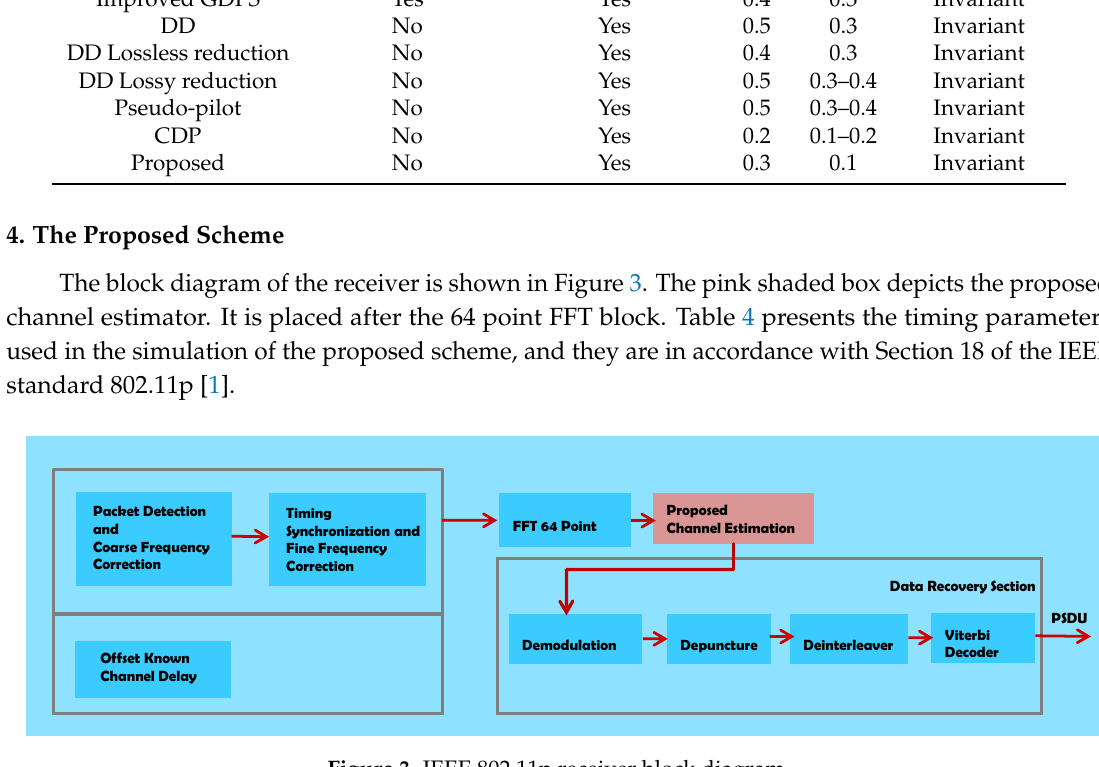
Figure 3. IEEE 802.11p receiver block